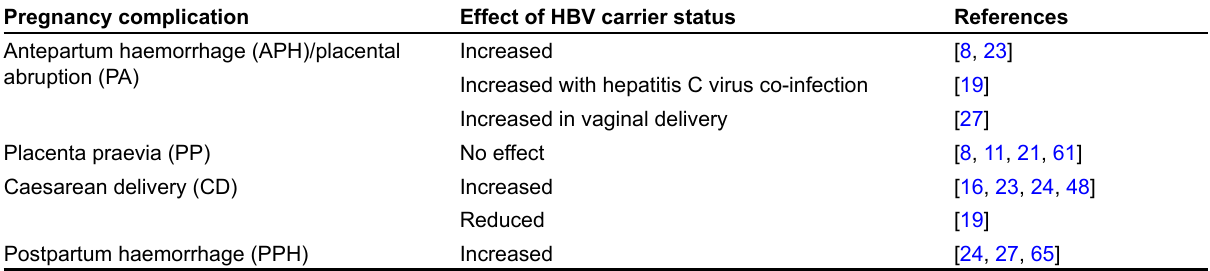
Table 2. Pregnancy complications in which demonstrable effects of chronic HBV infection have been reported ( continued